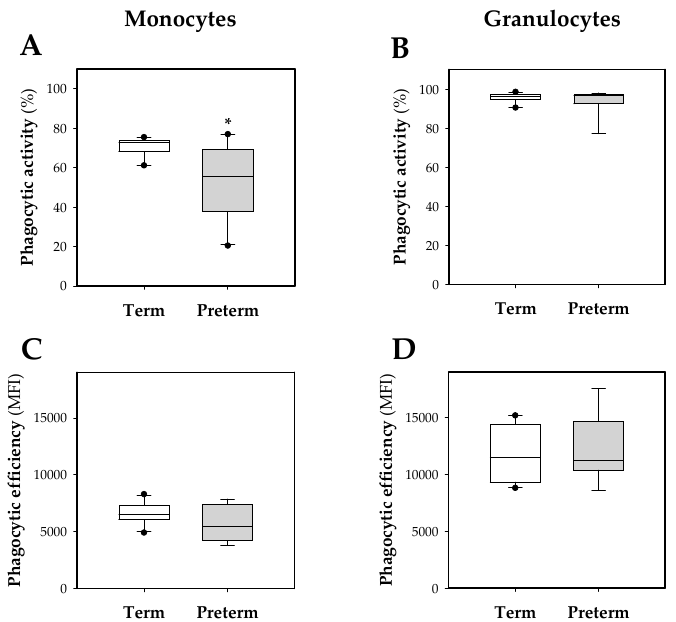
Figure 4. Box plot of phagocytic function of blood leukocytes. Phagocytic activity and efficiency in monocytes ( A , C ) and granulocytes ( B , D ). Line indicates the median, box shows the interquartile range (IQR) and the whiskers are 1.5 × IQR ( n = 10 pups per group). Statistical differences: * p < 0.05 vs. term group.